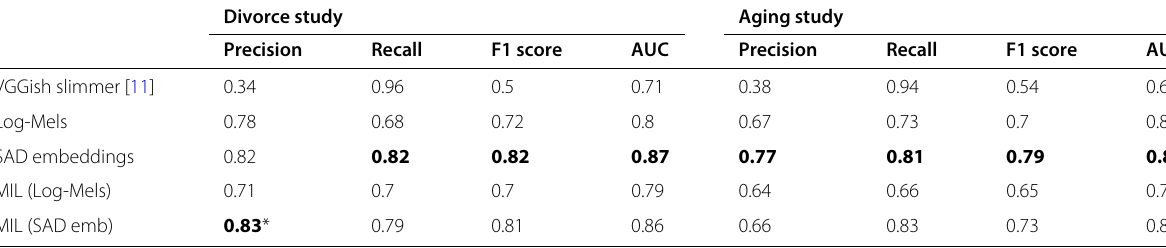
Table 3 Foreground detection results on utterance (bag) level approaches Divorce study Aging